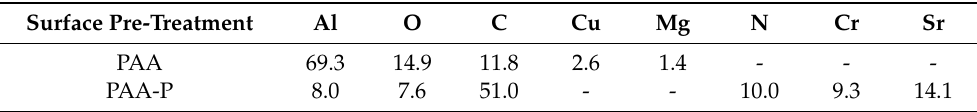
Table 3. Average chemical composition (in wt %) of the PAA and PAA-P pre-treated AA2024-T3 surface after 28 days of accelerated aging by EDS analysis.